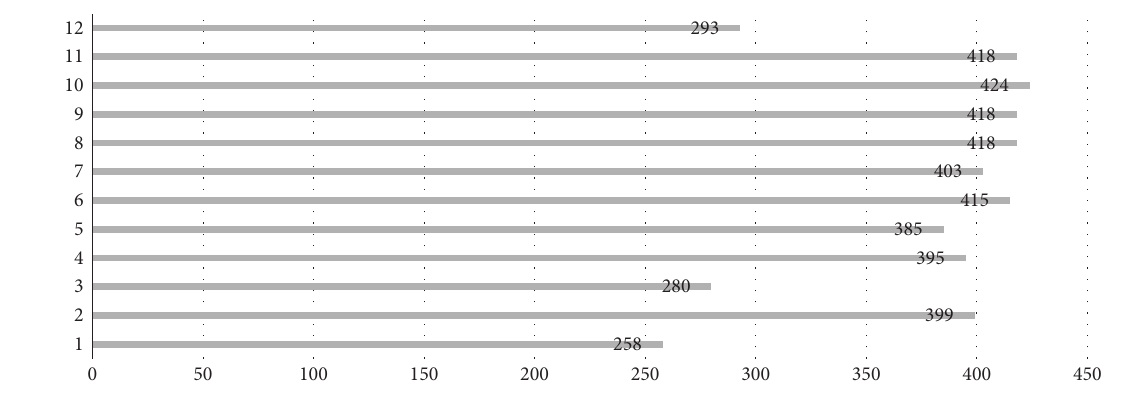
Figure 8: Category IV: decision-making.